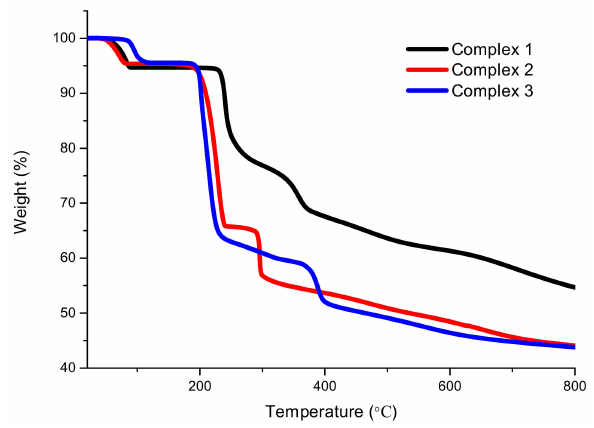
Figure 7. TGA curves of complexes 1 – 3